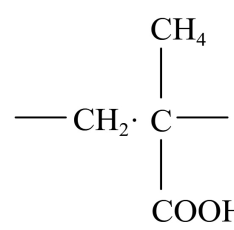
Figure 2. Schematic diagram of the molecular structure of the D113 resin. The biogas slurry was obtained from the anaerobic reactor using straw and pig ma- nure as raw materials, and the ammonia nitrogen concentration was 432.43 mg/L.